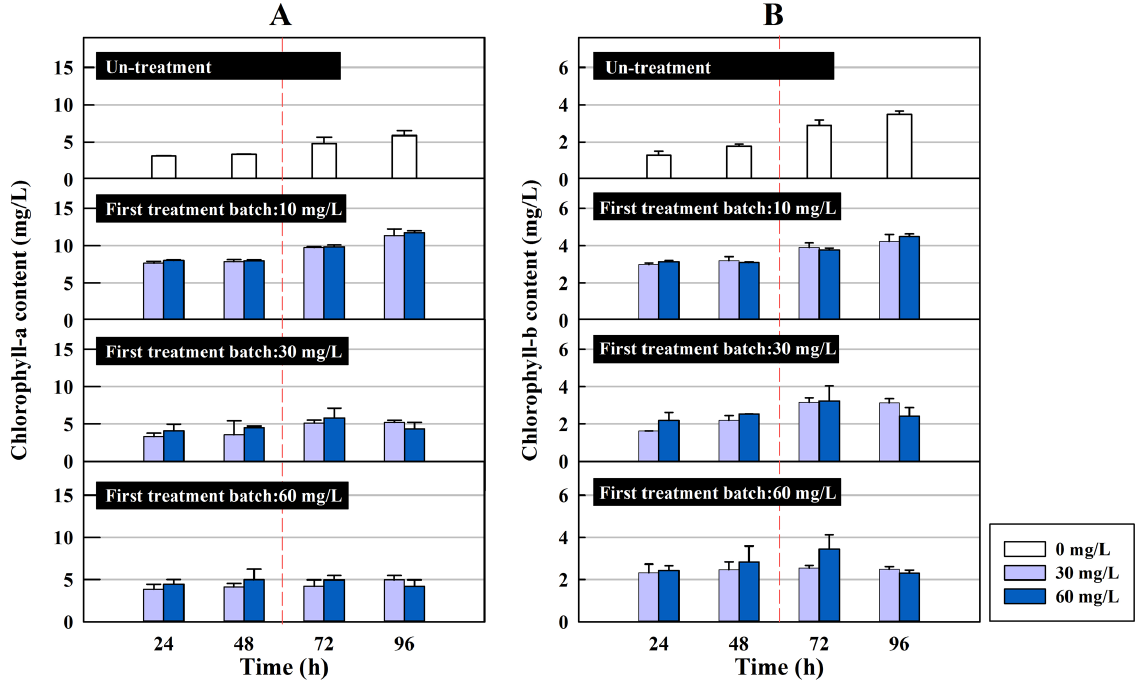
Fig 3. The chlorophyll content of C . pyrenoidosa in the second treatment batch. (A) The chlorophyll-a content of the algae in the second treatment batch at two concentrations (30 and 60 mg/L) after a first treatment batch at 10, 30 and 60 mg/L. (B) The chlorophyll-b content of the algae in the second treatment batch at two concentrations (30 and 60 mg/L) after a first treatment batch at 10, 30 and 60 mg/L. Algae with 0 mg/L of the antibiotic was used as the no-treatment group.